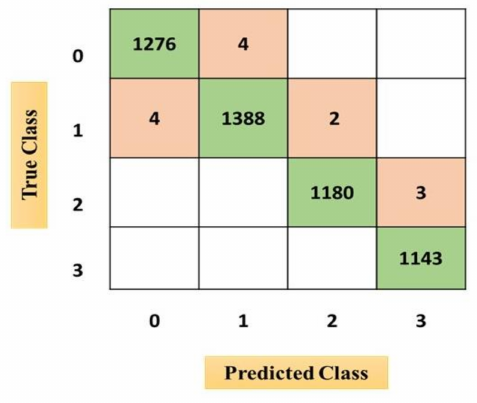
Figure 10. Confusion matrix for the one-dimensional convolutional neural